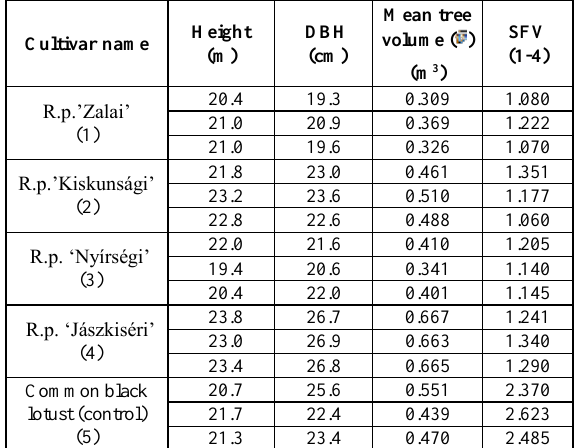
Table 1. Stand characteristics of black locust cultivars at the age of 35 years